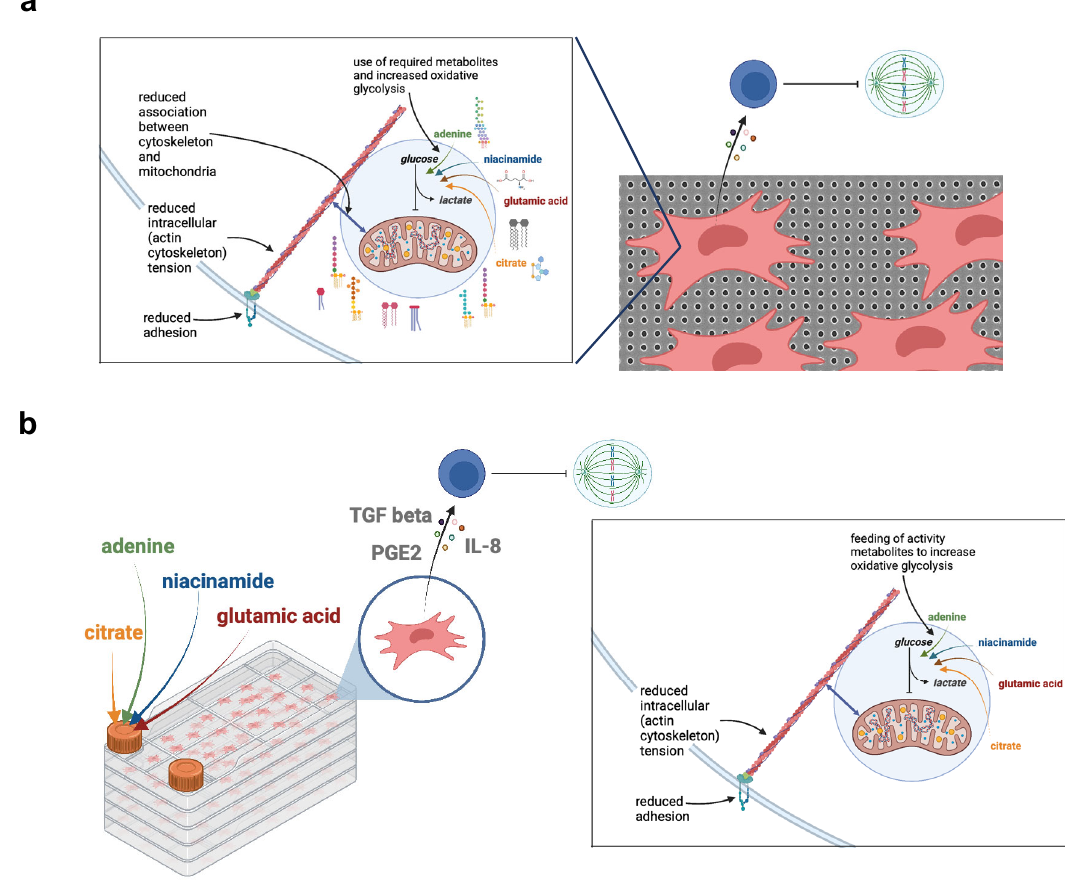
Fig.7|Schematicillustratingmain fi ndings.a CultureontheSQnanotopography causes a lowering of cell adhesion, cytoskeletal tension and mitochondrial asso- ciation with actin micro fi laments. This results in use of adenine, niacinamide, glu- tamic acid and citrate by the cells to drive glycolysis resulting in reduced T cell proliferation. b Addition of the glycolysis-driving metabolites into large-scaleMSC